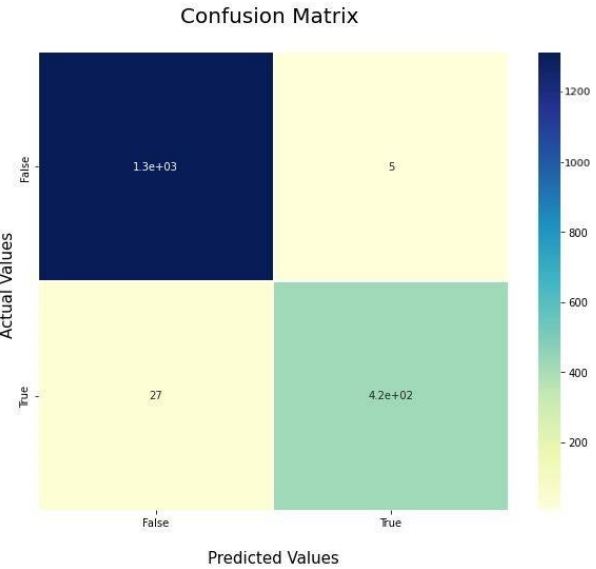
Figure 11. Confusion matrix before using cGAN.